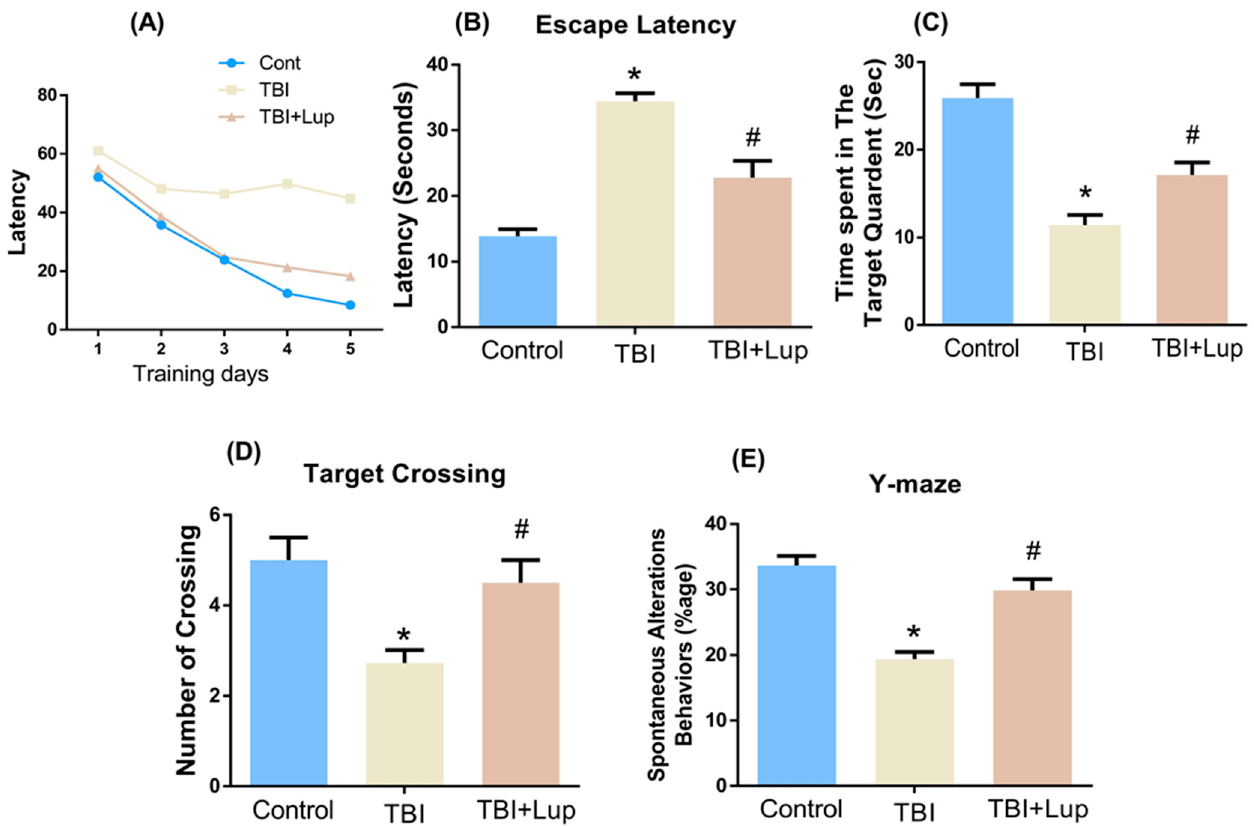
Figure 5. Lupeol improved memory, learning, and cognitive behavior in TBI-treated mice: ( A ) mean escape latency to reach the hidden platform during training (5 days) with its representative trajectories at day 6 and ( B ) at the 6th day after training; ( C , D ) the time spent in the target quadrant where the hidden platform was previously present and the number of crossings over that location in the absence of a platform; ( E ) the Y-maze analysis representing the spontaneous alteration behaviors of mice and its representative trajectories. Asterisk (*) sign indicates significant difference from the normal saline-treated group; hash (#) sign indicates significant difference from the TBI-treated group. The density values are expressed in arbitrary units as the mean ± SEM of the indicated proteins ( n = 6 animals per group). Significance = * p ≤ 0.05, # p ≤ 0.05.